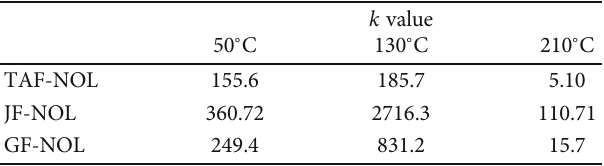
Figure 3: DMA performance data at various frequencies: (a – c) twisting abaca fi ber-NOL composite; (d – f) jute fi ber-NOL composite; (g – i) glass fi ber-NOL composite. Table 2: k values of NOL rings of di ff erent